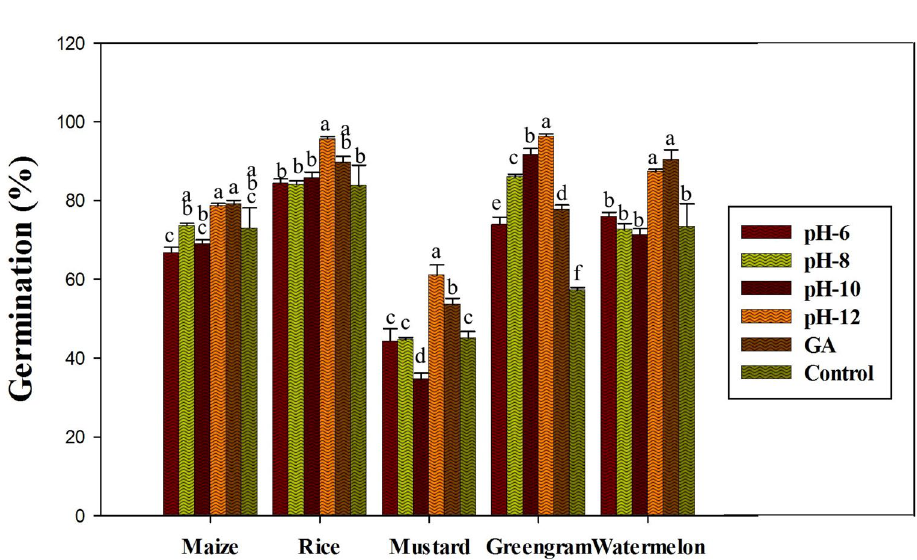
Figure 2. Germination of maize, rice, mustard, greengram and watermelon with different Fe 3 O 4 -NPs synthesized by different pH. Data are mean ± SD. Each group without sharing letter mean statistical significance ( P ≤